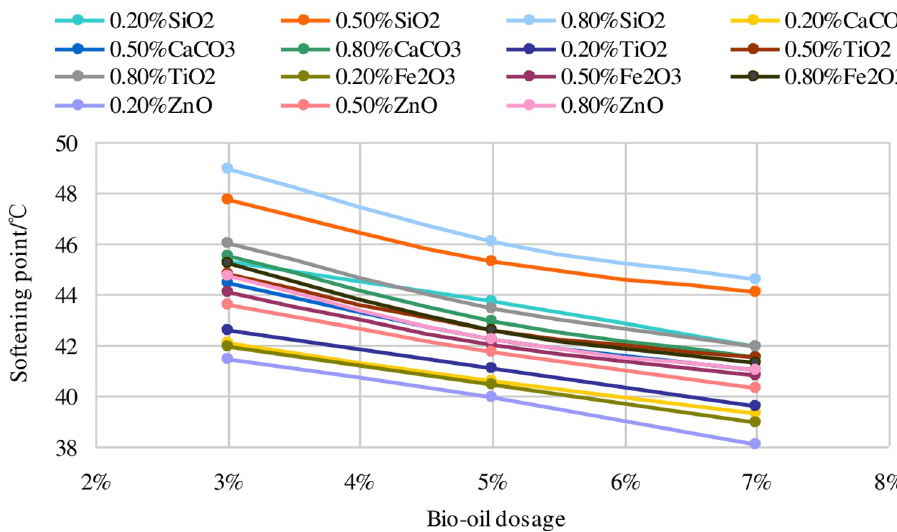
Fig 2. Trend of softening point with different bio-oil